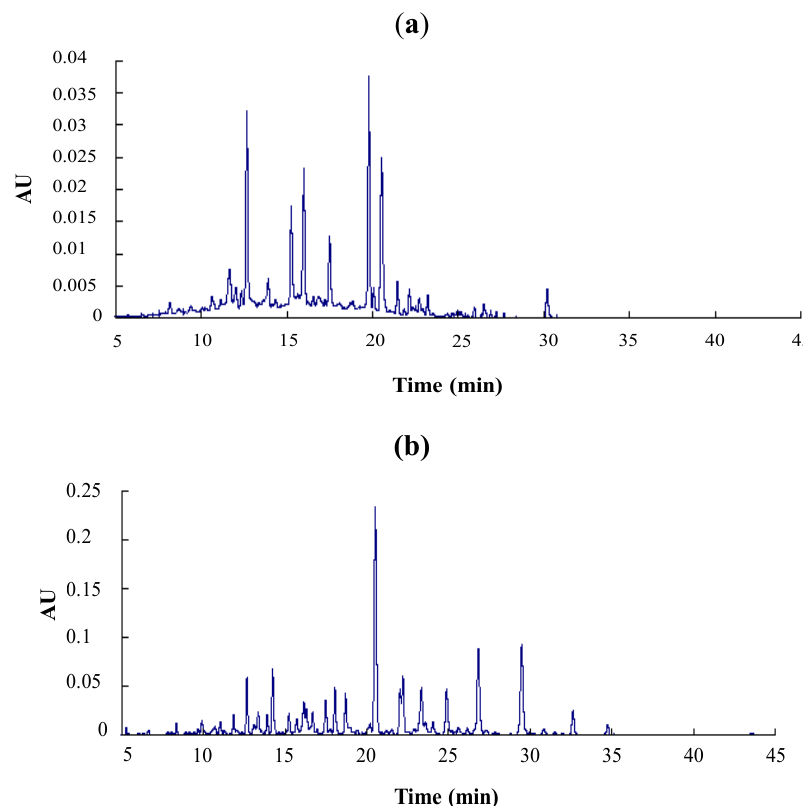
Figure 1. RP-HPLC chromatogram of LSOPC ( a ) (0.6 mg/mL) and their urinary metabolites in rats; ( b ) of the experimental group with an LSOPC administration dose of 300 mg/kg body weight; ( c ) of the control